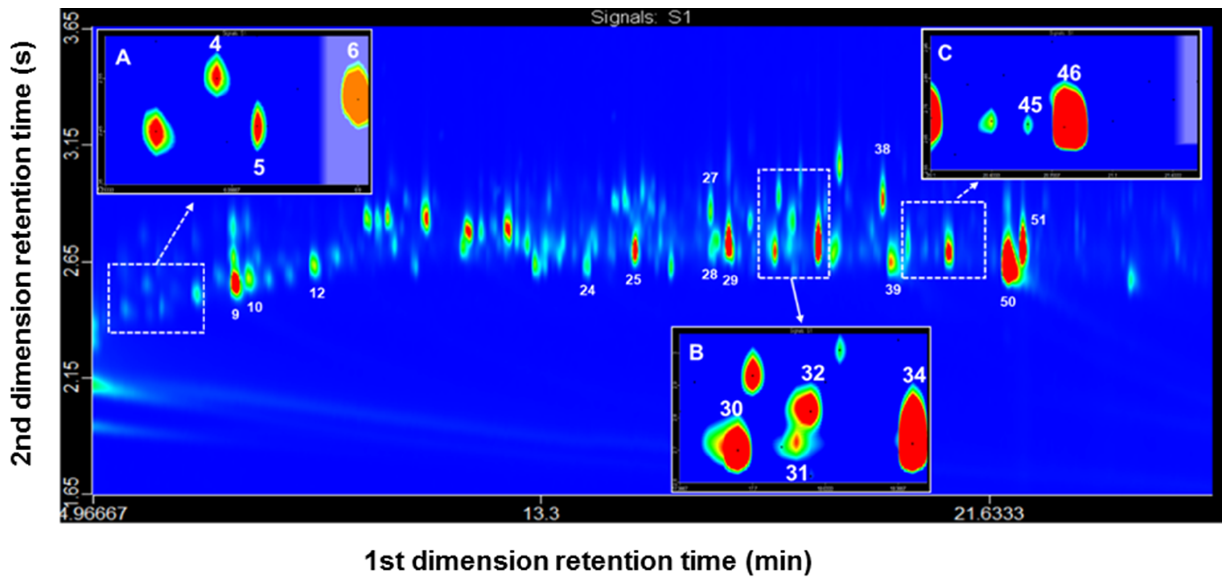
Figure 1. GC × GC-FID chromatogram (2D color plot) of an extract obtained by HS-MonoTrap™ of G. platensis virgin males. ( A ) Close up at retention time 5.2–7 min; ( B ) Close up at retention time 17.35–18.35 min; ( C ) Close up at retention time 20.1–21.6 min. Analytical conditions are described in Section 4.6. Peaks are numbered according to Table 1.